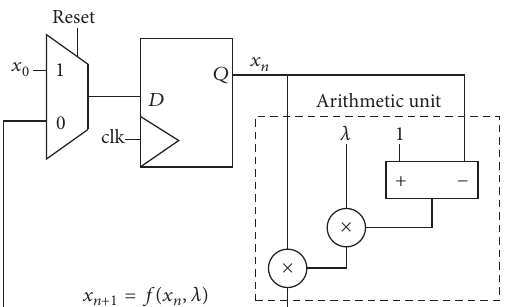
Figure 19: Stream cipher system for encryption